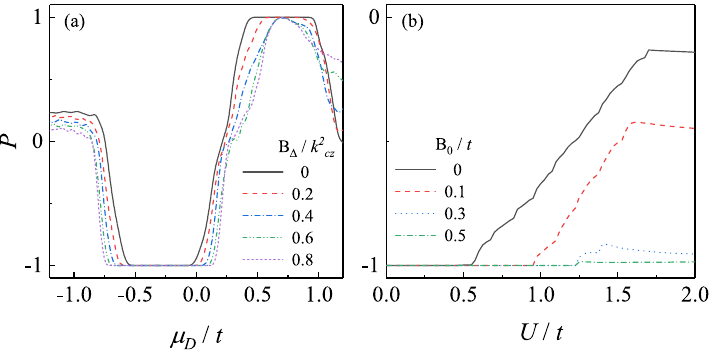
Figure 4. The dependence of spin polarization on ( a ) gate voltage and ( b ) barrier with different Zeeman terms. The parameters in ( a ) are the same with those in Fig. 2 with B 0 = 0.2 t while parameters in ( b ) are the same with those in Fig. 3 with µ D = − 0.2 t .